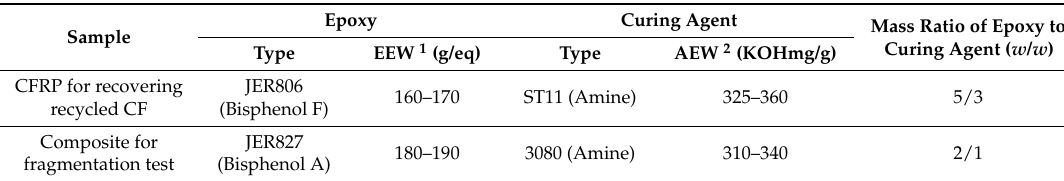
Table 1. Materials for